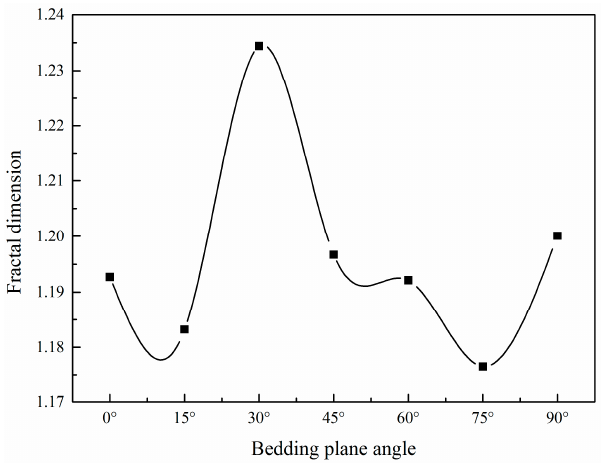
Figure 10. FDs at different BP angles. The FD reached a maximum at 30°.